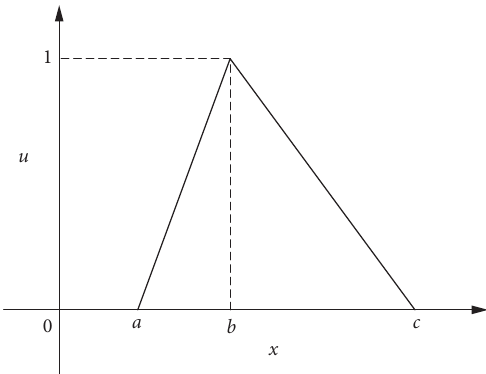
Figure 5: Triangular fuzzy number